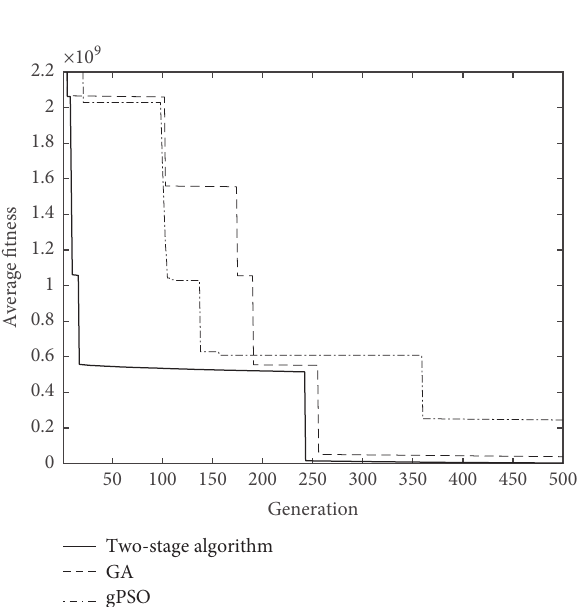
Figure 10: Converge behavior of a problem